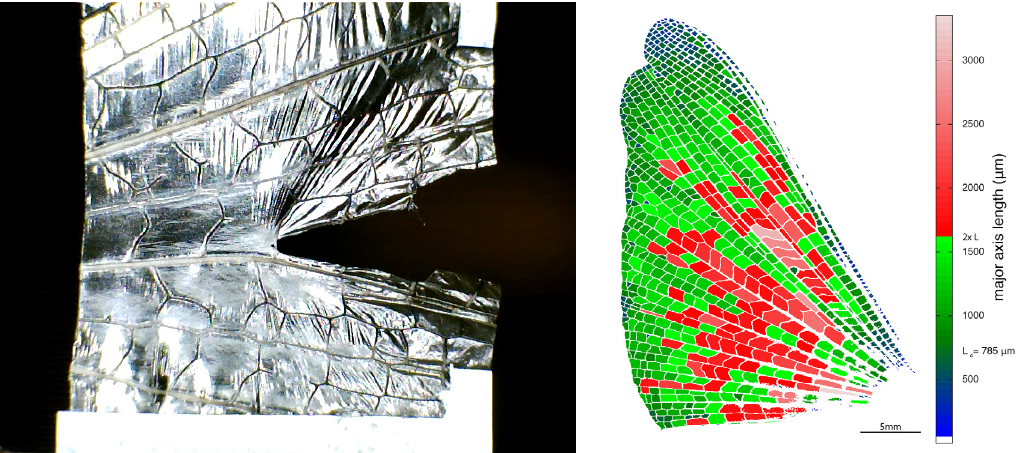
Figure 1: The image on the left shows a fracture toughness test on material from the wing of a locust, with a propagating crack arrested at a vein. The image on the right shows the entire wing; the different colours indicate the local spacings of the